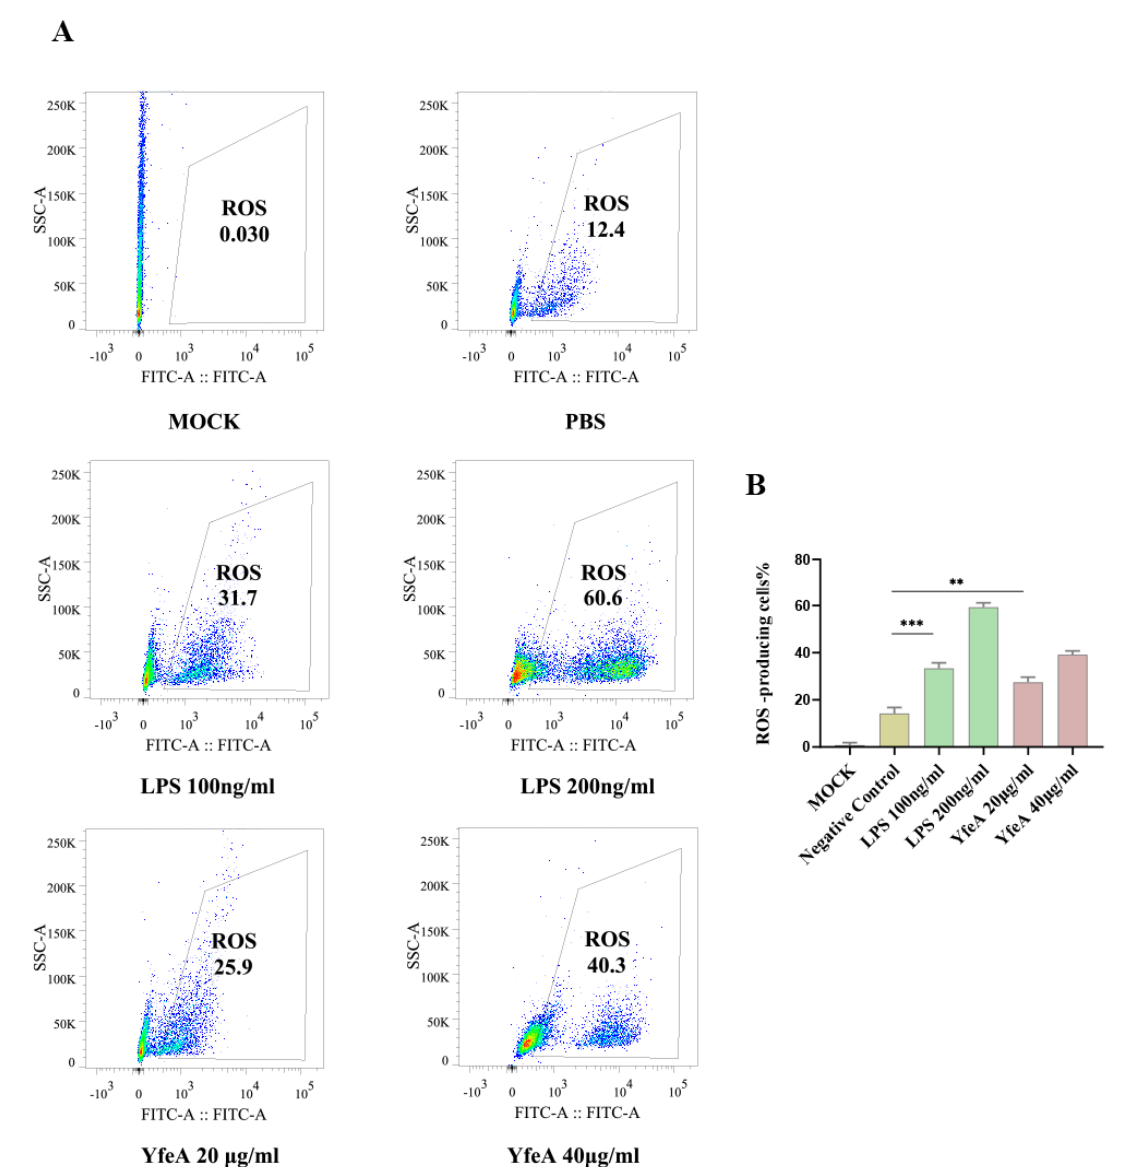
Figure 5. rYfeA protein triggered intracellular level of ROS. ( A ) The FCM detection of the levels of ROS induced by YfeA (20 and 40 µ g/mL) and LPS (100 and 200 ng/mL). (excitation wavelength: 488 nm, emission wavelength: 525 nm, a FITC-range monitoring scope). RAW 264.7 were plated into 6-well plates at a density of 2 × 10 6 cells/well overnight and then stimulated with LPS or YfeA for 12 h prior to ROS measurements. The DCFH-DA probe detected the intracellular ROS level. After being oxidized by ROS, DCFH-DA transformed to DCF, with a green fluorescence upon irradiation of a 488 nm laser. The fluorescence intensity of DCF was used to evaluate intracellular oxidative stress. ( B ) Statistical results of ROS levels in each treatment-group. Significant differences between groups are indicated by * p < 0.01 and ** p <